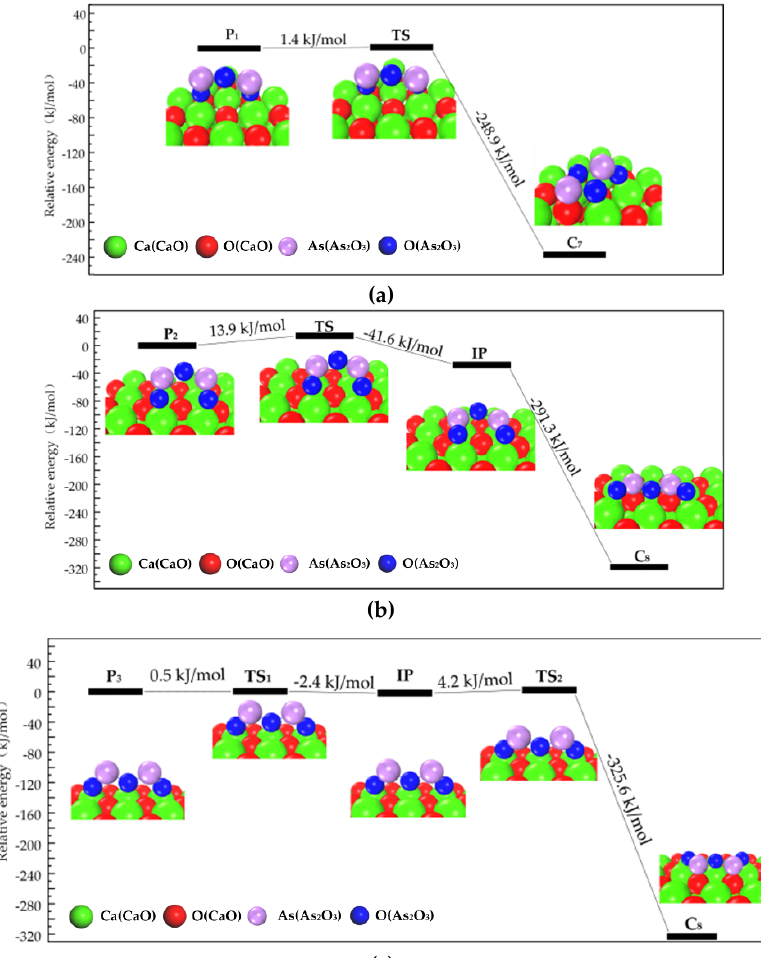
Figure 1. Structures and energies during transformation process of physisorption structures to chemisorption structures. ( a ) Reaction path of physisorption structure 1; ( b ) Reaction path of physisorption structure 2; ( c ) Reaction path of physisorption structure 3.